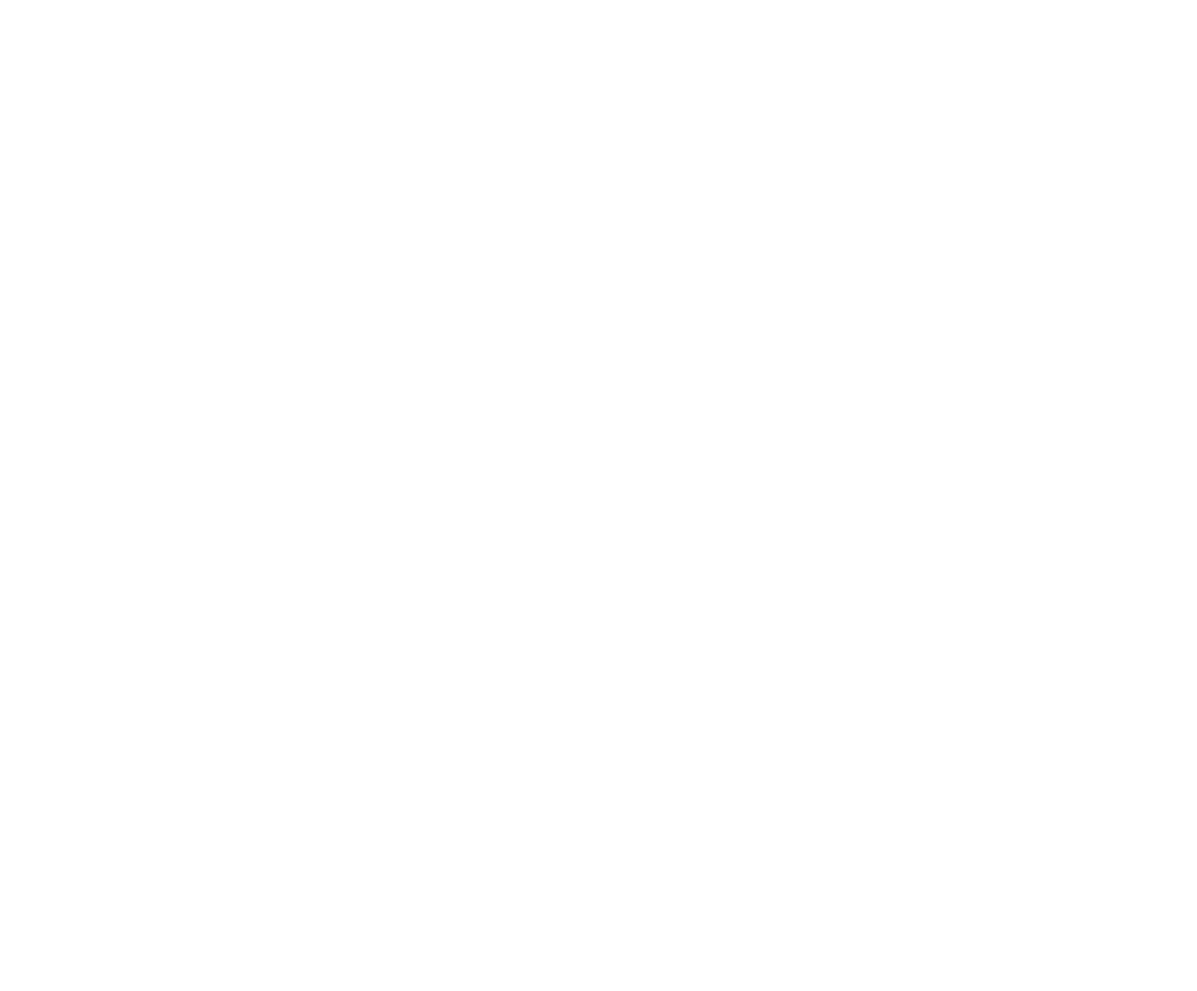
FIGUREA1 | Spatial maps ( z -score maps, same in FiguresA2–A6) of components in module I for HCs and SZs. Hubs of this module in each group are labeled. Each column shows one component in axial, sagittal, and coronal views. In this module, both groups have six common components